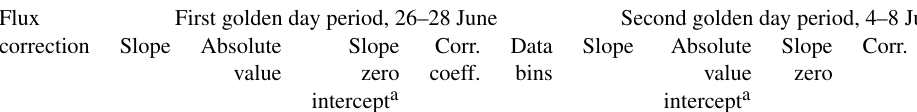
Table 3. Results of the comparison of the measured and the modeled flux data for different correction methods with an orthogonal regression for binned data points for the clearing with and without footprint weighting (for details, see Fig. 5; absolute values in Wm − 2 or µmolm − 2 s − 1 for the